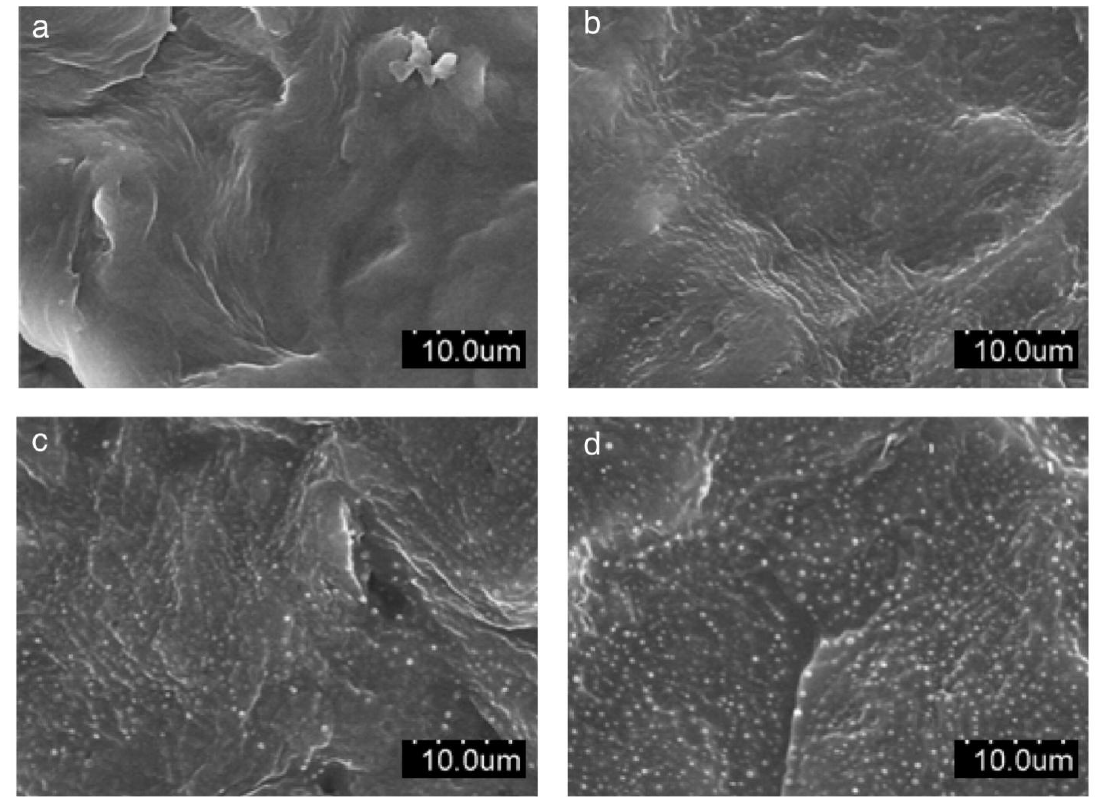
Figure 5. SEM phase morphology of ( a ) neat PCL, ( b ) CNC-1/PCL, ( c ) CNC-3/PCL, and ( d ) CNC-5/PCL samples